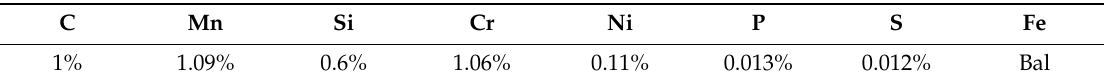
Table 1. Chemical composition of A485-1 steel (wt %) [28].